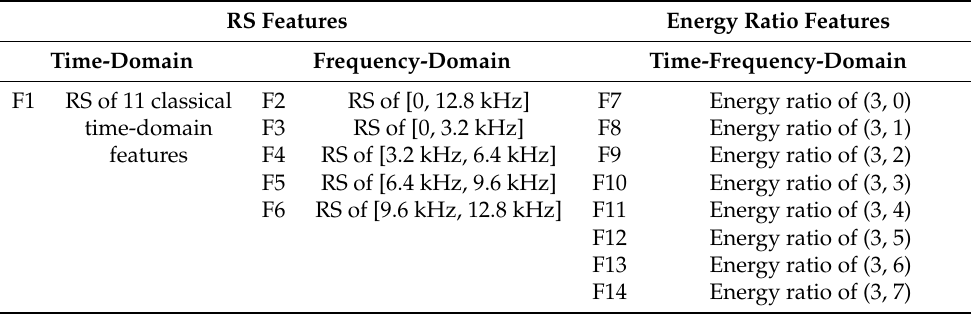
Table 1. Detailed features